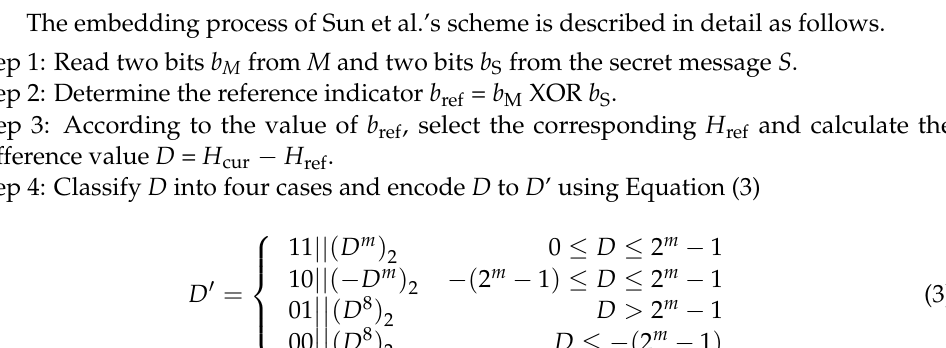
Figure 2. The current value H cur and its four reference